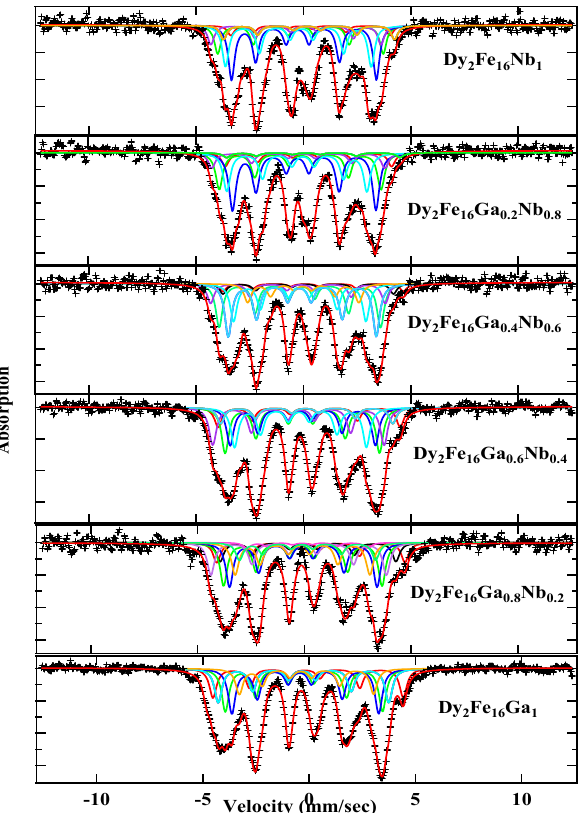
Figure 6. RT Mössbauer fitted spectra for Dy2Fe16Ga1 − x Nb x . Figure 6. R T Mössbauer fitted spectra for Dy Figure 6. R T Mössbauer fitted spectra for Dy 2 Fe 16 Ga 1 − x Nb x .